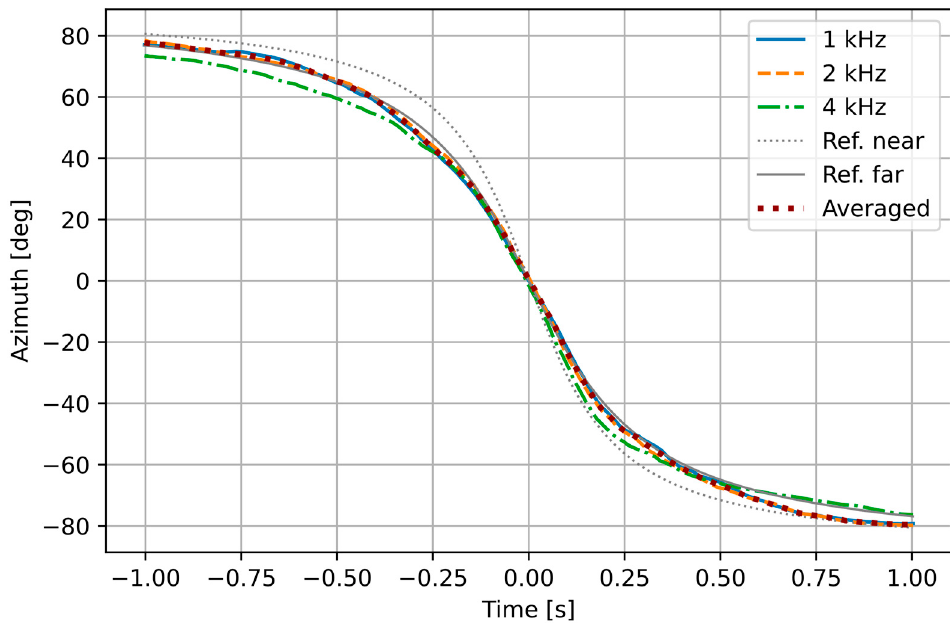
Figure 3. Azimuth measured by the AVS and computed by the model.